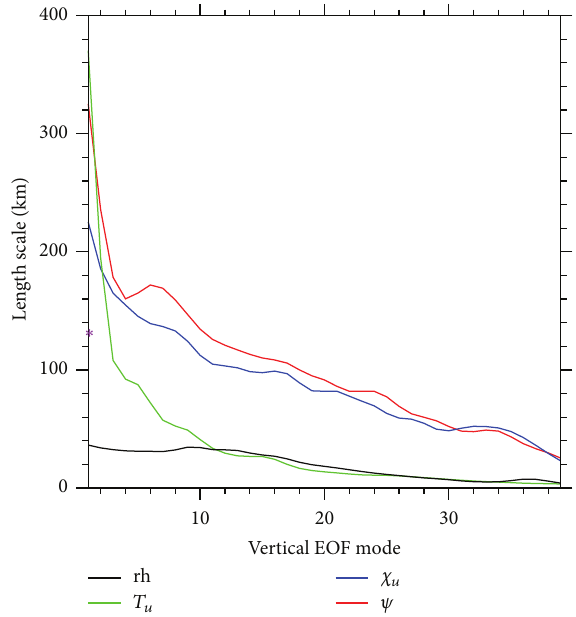
Figure 1: Length scales of forecast errors of the WRFVAR control variables of stream function ( 𝜓 ), unbalanced velocity potential (𝜒 𝑢 ) , unblancedtemperature( 𝑇 𝑢 ),andrelativehumidity(rh),withrespect to the vertical EOF mode, computed using 3km WRF forecasts over a domain that covers a region of N24 ∘ –N49 ∘ and W116 ∘ –W74 ∘ in the USA. Note that the surface pressure has only one mode (indicated by the purple ∗ ) because it is a 2D